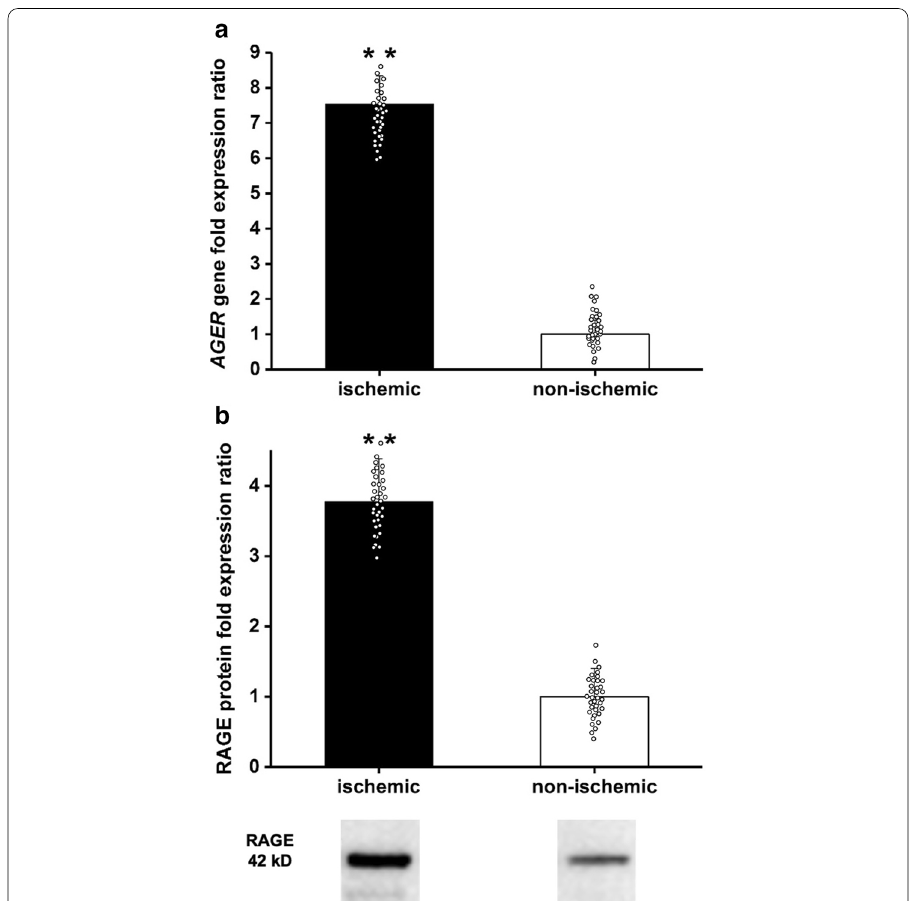
Fig. 3 AGER (RAGE) gene quantification in murine tissue homogenates from ischemic and non-ischemic hindlimbs at one week after HLi ( a ). Western blot depicting RAGE levels in murine tissue homogenates from ischemic and non-ischemic hindlimbs at one week after HLi ( b ). (**) - p < 0.01. Data represent mean and mean squared